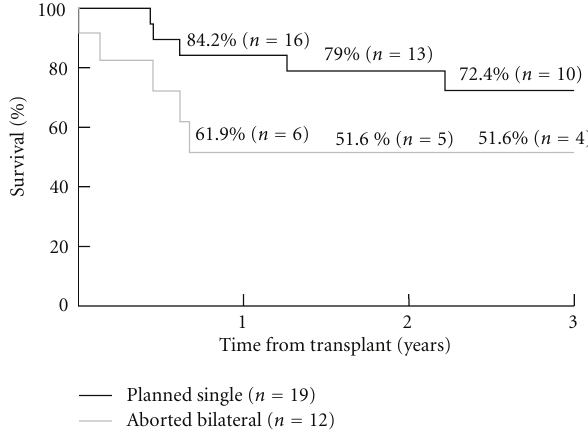
Figure 1: Kaplan Meier Survival stratified by